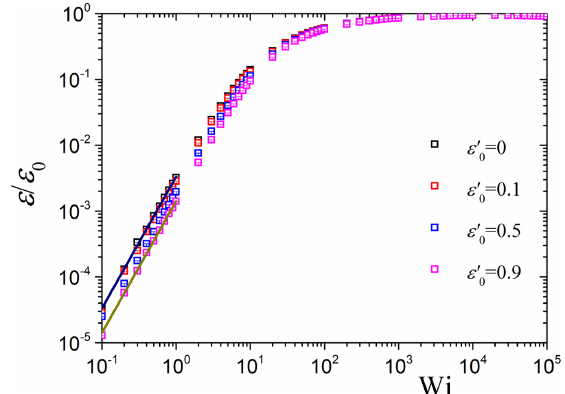
Figure 3. Predictions for the variable link tension coefficient, ε / ε 0 = S 2 in planar elongational flow as a 2 function of dimensionless elongation rate Wi for N = 100 ( Z ≈ 33 entanglements) and various values = 0 (dark blue) and 0.9 of ε (cid:48) . The thick lines give the analytical predictions of Equation (23) when ε (cid:48) 0 0 (dark yellow). The dependency of Γ 1 on ε (cid:48) determines their offsets and is relatively weak for any N . 0 For N > 2 the coefficient Γ 1 decreases monotonically with increasing ε (cid:48) , starting from Γ 1 = 0.125 at ε (cid:48) = 0. For any N ≥ 20 one has Γ 1 ≈ 0.081 at ε (cid:48) = 0.9 (and Γ 1 ≈ 0.078 at ε (cid:48) =